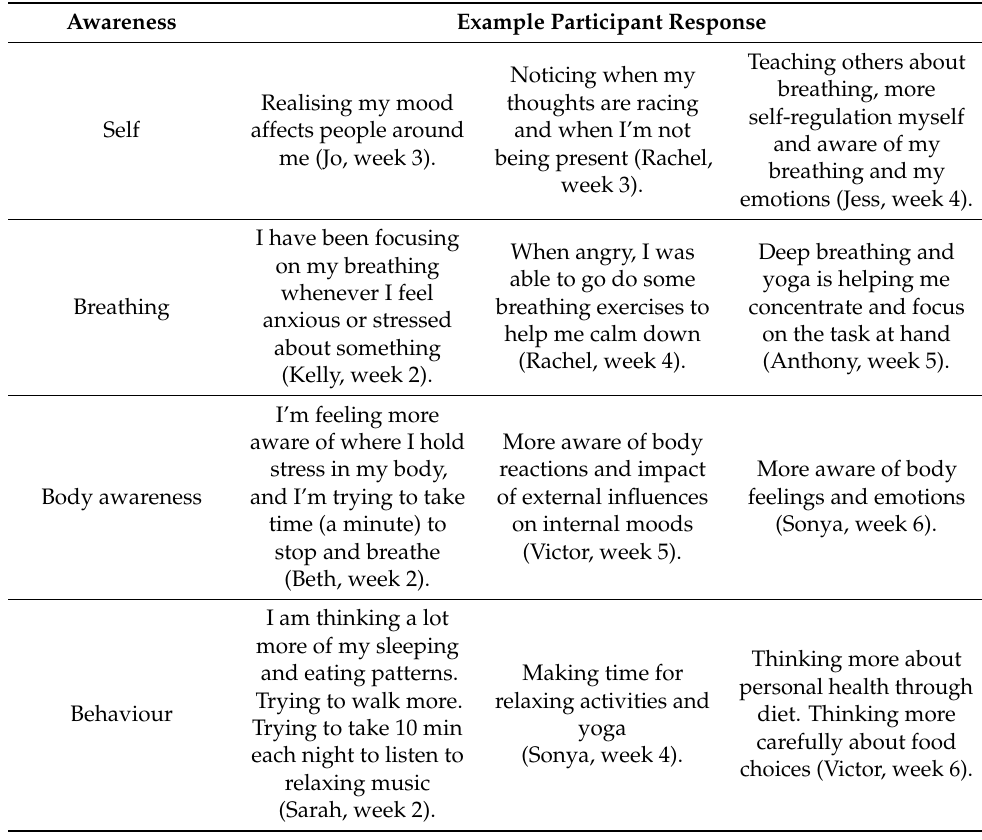
Table 2. Summary of participant response examples from weeks 2 to